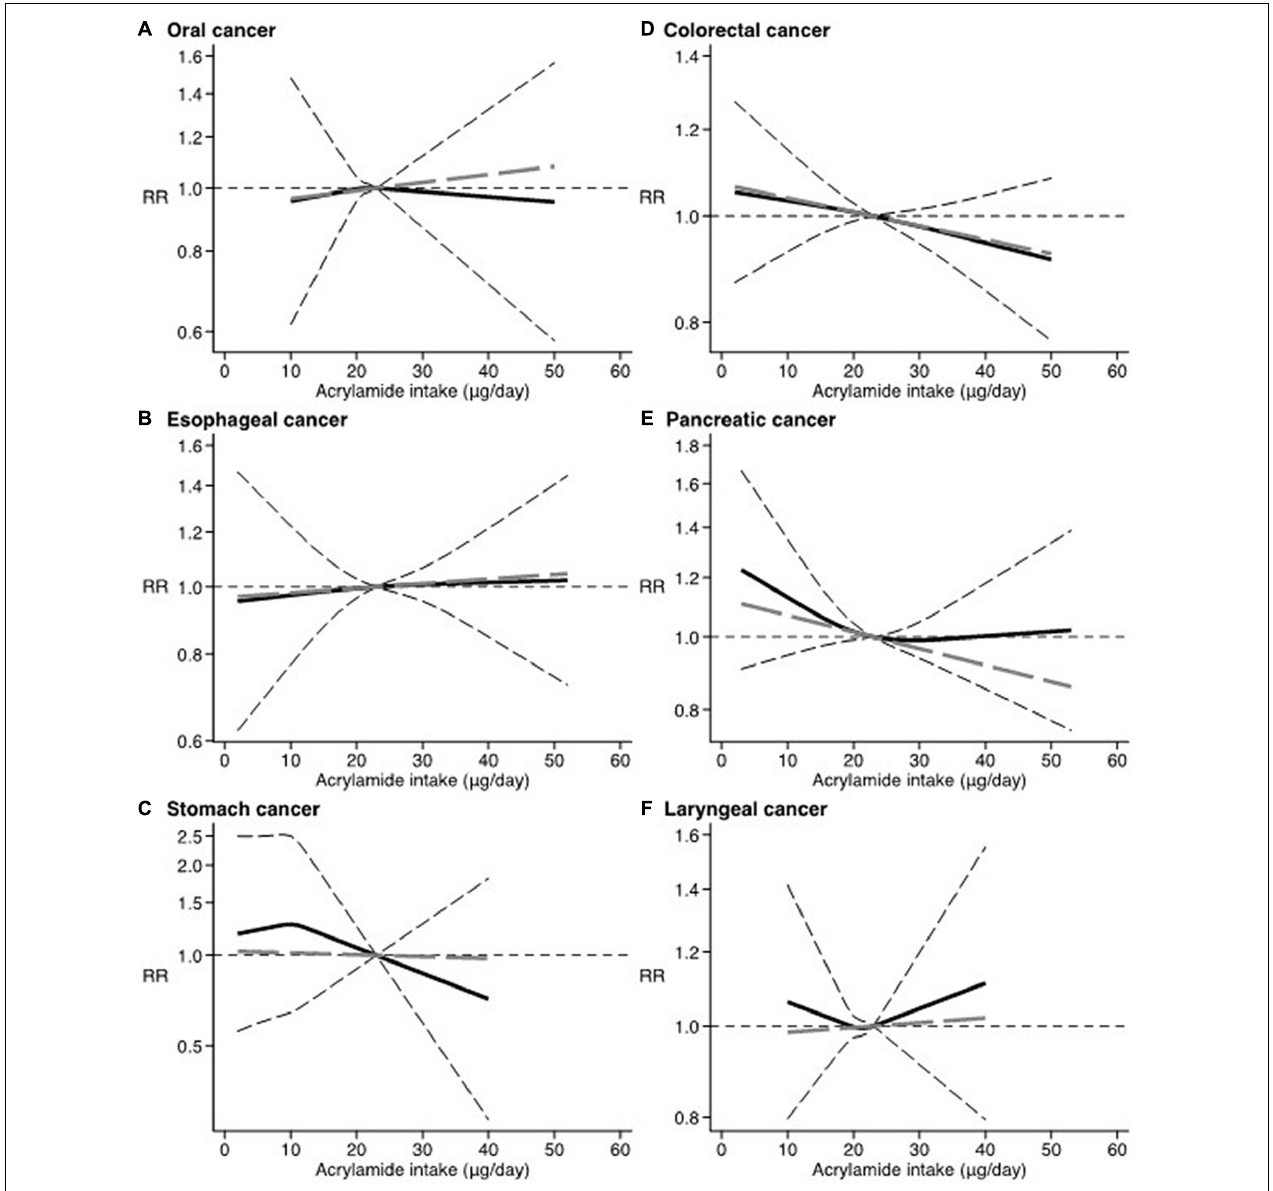
FIGURE 2 | Dose-response. Spline curve (black solid line) with 95% confidence limits (black dashed lines). Linear trend (gray long-dashed line). RR, relative risk. Reference value of dietary acrylamide exposure: 23 µ g/day. (A) Oral cancer (22, 31). (B) Esophageal cancer (14, 17, 22, 29, 32). (C) Stomach cancer (17, 29). (D) Colorectal cancer (17, 21, 22, 28, 29, 33). (E) Pancreatic cancer (17, 23, 71, 72). (F) Laryngeal cancer (22,